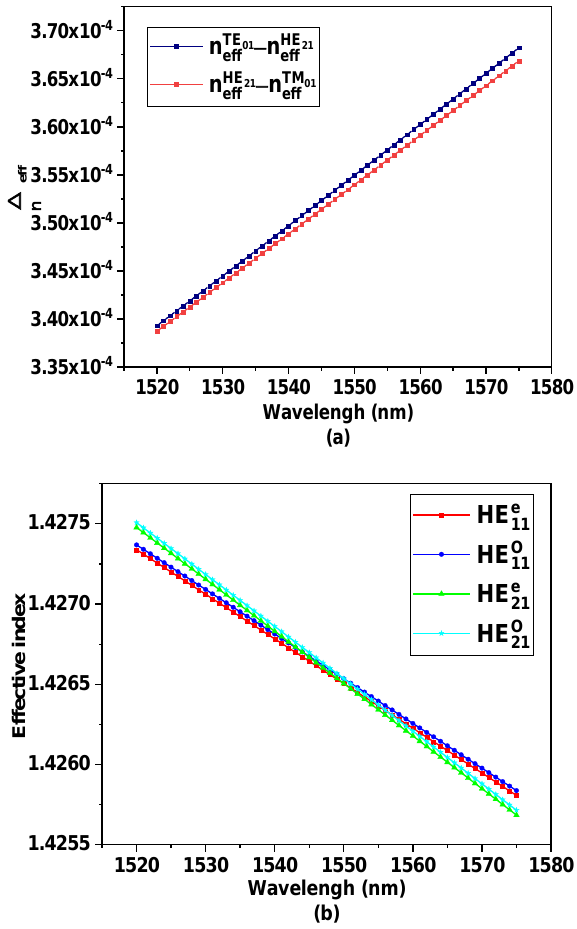
Figure 2. ( a ) ERI differences between different vector modes in few-mode core. ( b ) Dispersion curves of the odd mode and even mode of HE 11 in the SMFC and HE 21 in the FMFC.